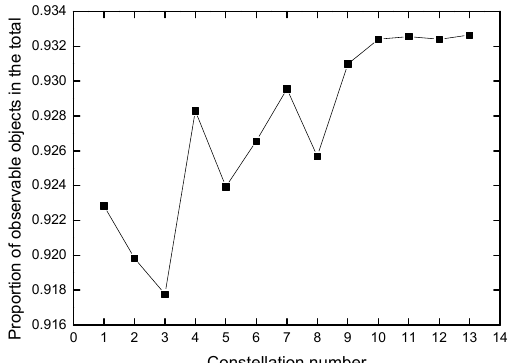
Figure 9. The proportion of space objects within the detectable range of the different constellation configurations to the total.